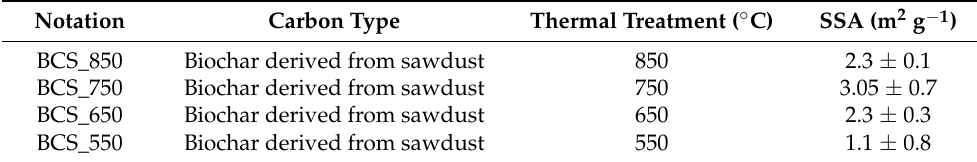
Table 1. Notation and specific surface area (SSA) values of various biochar